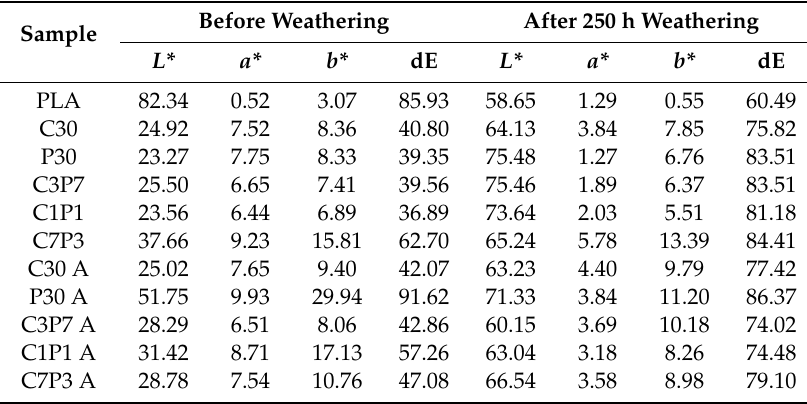
Figure 4. Cumulativecolour change (dE) over time for untreated and alkali-treated CF/PALF/PLA biocomposites. Table 5. Colour change parameter summary sheet of PLA and untreated and alkali-treated CF/PALF/PLA composites using the CIELab system.